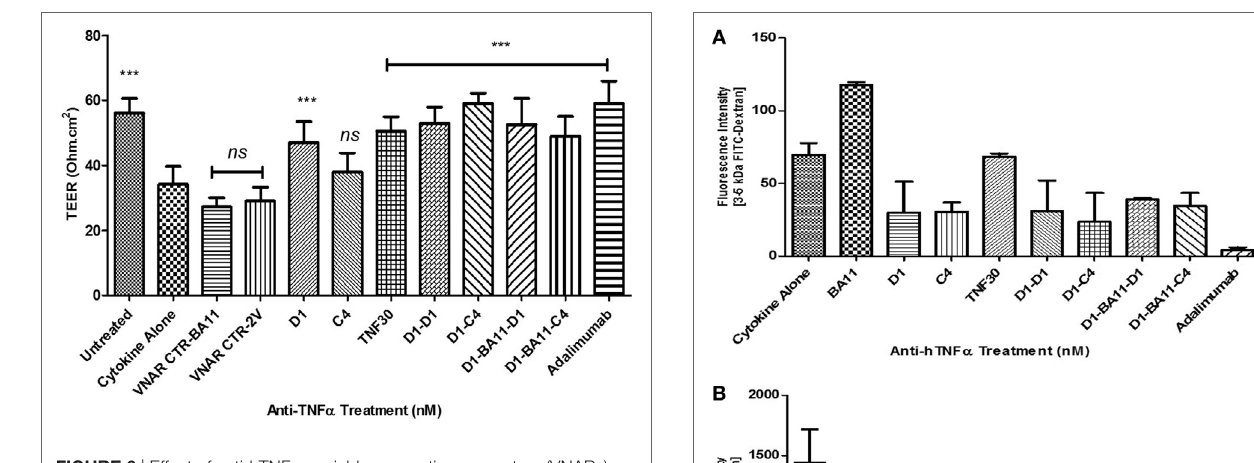
FigUre 6 | Effect of anti-hTNF- α variable new antigen receptors (VNARs) on trans-epithelial resistance disruption in Caco-2 cell model of cytokine- induced intestinal barrier dysfunction. Monolayer cells were treated with 10 ng/ml hTNF- α and IFN- γ . All VNAR monomers were added at a final concentration of 50 nM while multivalent domains and adalimumab were added at a final concentration of 25 nM. Results shown are the mean ± SD ( n = 1 with ≥ 8 replicates per experiment). Results were statistically analyzed using a one-way ANOVA with Dunnett’s post hoc test [*** where P < 0.0001; not significant (ns) where P > 0.05]. VNAR 2V is an isotype control isolated from a naïve library, and has no inherent affinity for any known target antigen (33, 40). VNAR BA11 has been described elsewhere in this